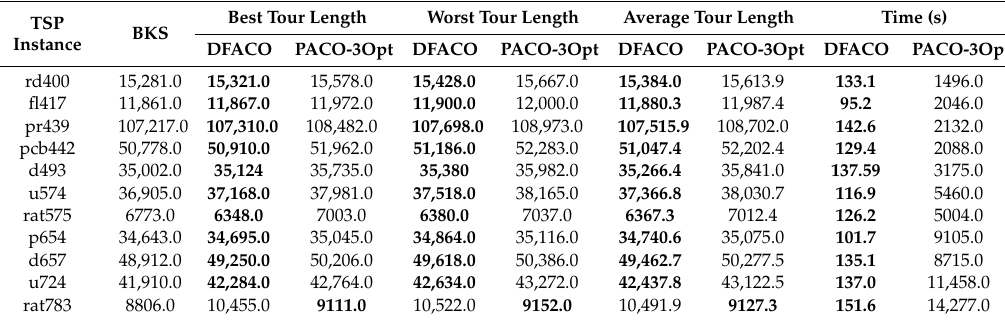
Table 4. DFACO and PACO-3Opt comparison for large-scale